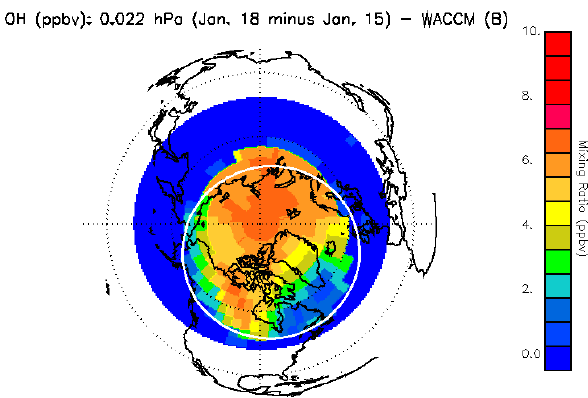
Fig. 4. WACCM3 B average OH predictions at 0.022hPa ( ∼ 75km) on 18 January 2005 (after SPE) minus those on 15 January 2005 (before SPE). For added clarity, the results from the WACCM3 sim- ulations are only shown from 44–90 ◦ N. The MLS averaging kernel (AK) was used to sample the WACCM3 results. The polar cap edge (60 ◦ geomagnetic latitude) is indicated by the white circle.